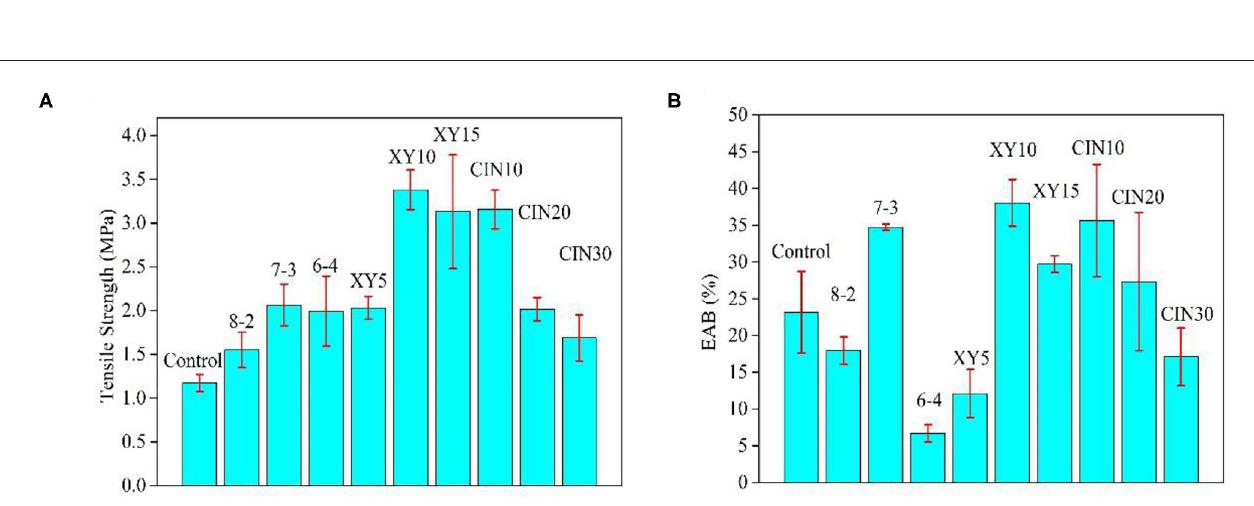
FIGURE 4 | Mechanical properties of GP-based composite films (A) tensile strength (TS) and (B) elongation at break EAB.